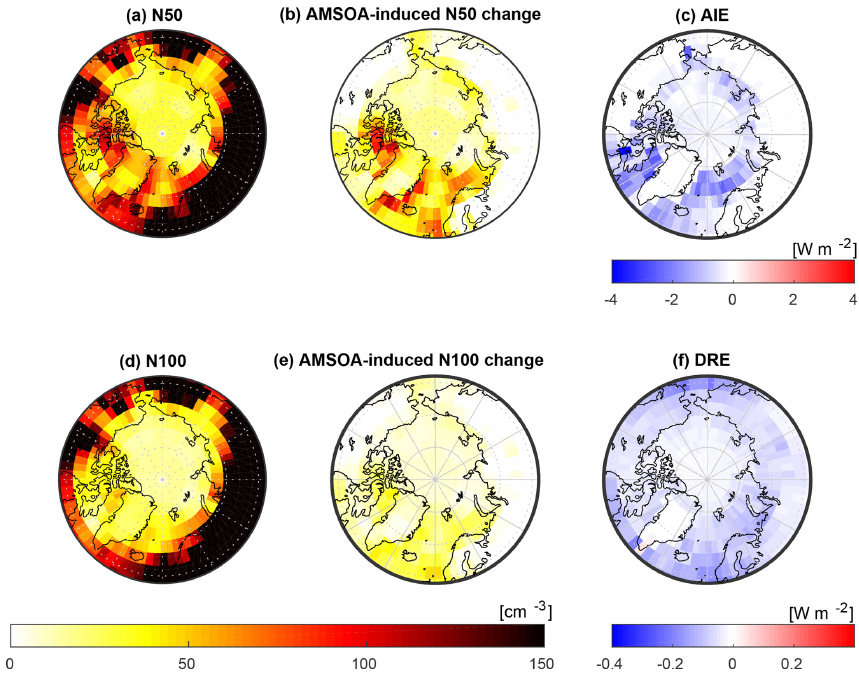
Figure 9. Impact of AMSOA simulated summertime- (July and August 2016) mean geographic distribution of surface-layer aerosol number concentrations with respect to (a) particles with diameters larger than 50nm (N50) for the BASE + TUNDRA + BIRDS + 100xnuc + AMSOAnv/sv simulation; (b) the surface-layer N50 difference for the BASE + TUNDRA + BIRDS + 100xnuc + AMSOAnv/sv simulation relative to the BASE + TUNDRA + BIRDS + 100xnuc simula- tion; (c) the aerosol indirect effect (AIE) at top of the atmosphere (methodology described in Sect. 2.2) between these two simulations, attributed to AMSOA; (d) similar to (a) but for N100; (e) similar to (b) but for N100 difference; and (f) direct aerosol effect (DRE) at top of the atmosphere (methodology described in Sect. 2.2) between these two simulations, attributed to